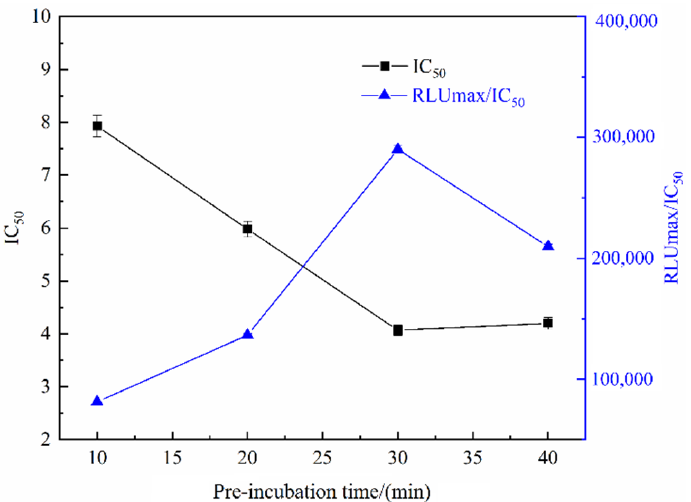
Figure 3. The IC 50 and RLUmax/IC 50 of ic-CLIEA with different pre-incubation time between ACE and its mAb for ACE detection.